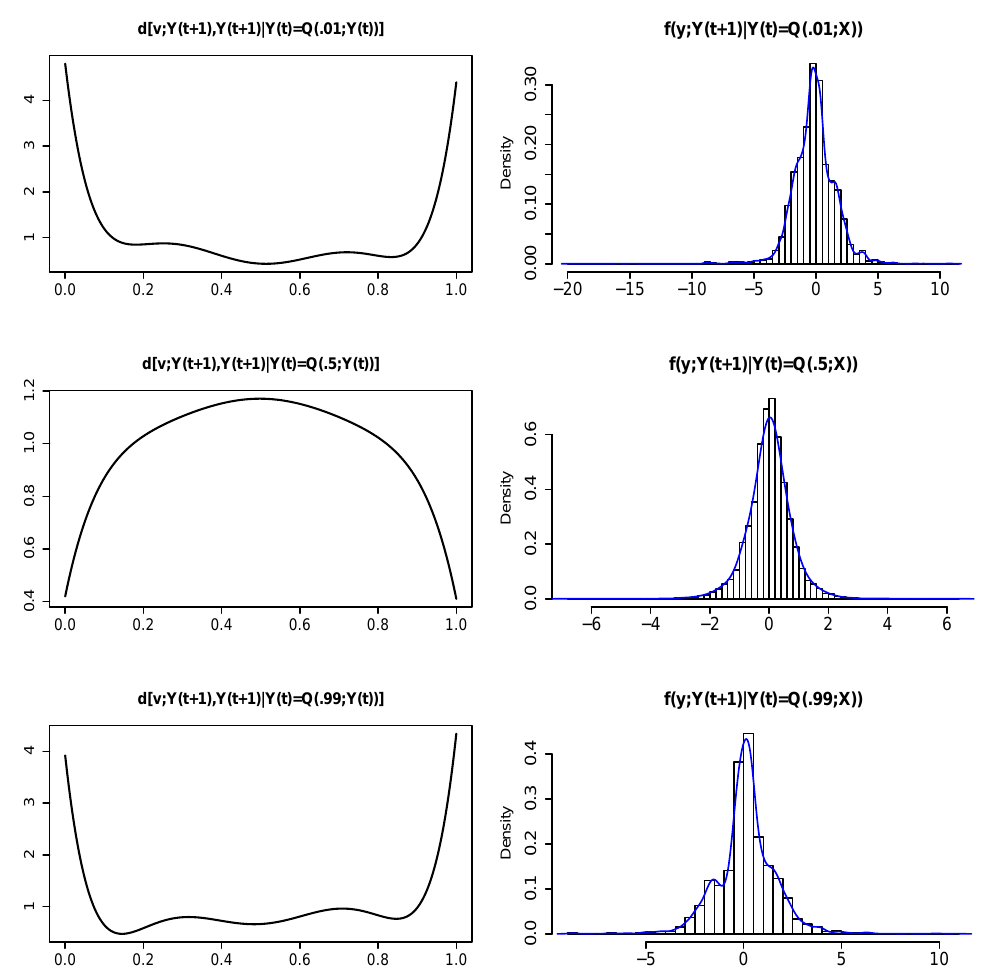
Figure 9. Each row displays the estimated conditional comparison density and the corresponding conditional distribution for u =